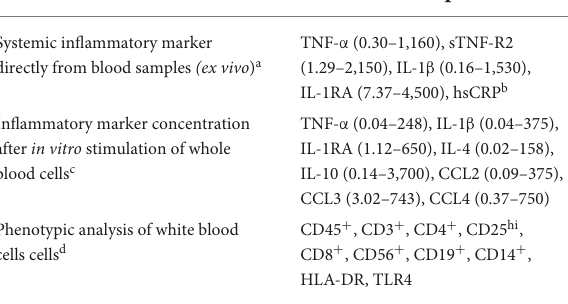
TABLE 1 Included neuroimmune